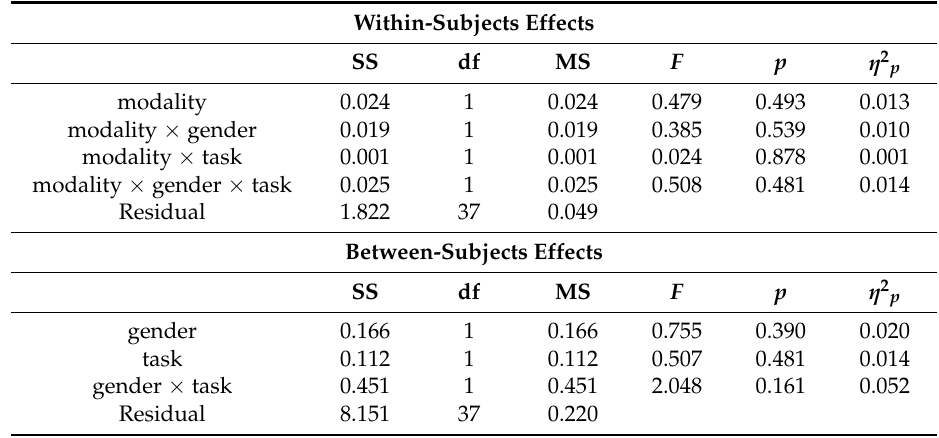
Table A5. Negative